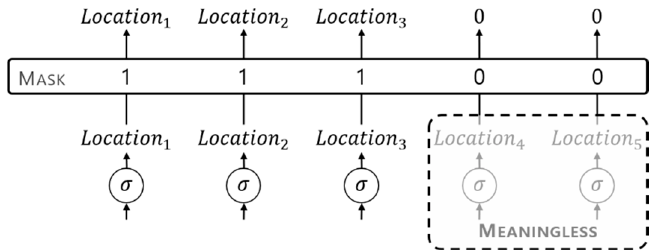
Figure 4. Masking result.